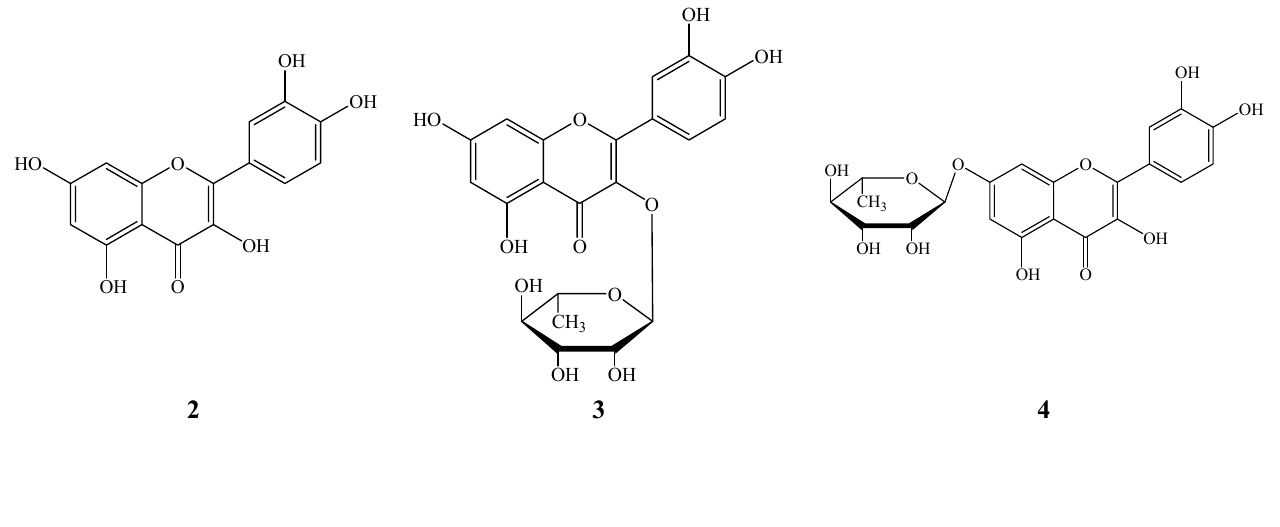
Figure 2. The structures of compounds 2-9 isolated from Hypericum japonicum